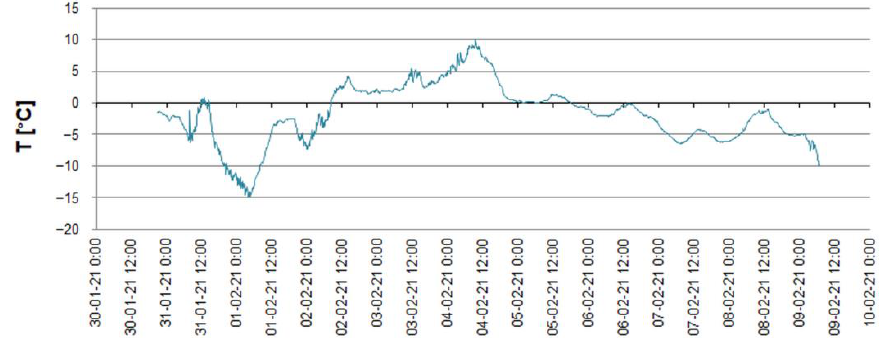
Figure 1. External air temperature during measurements.